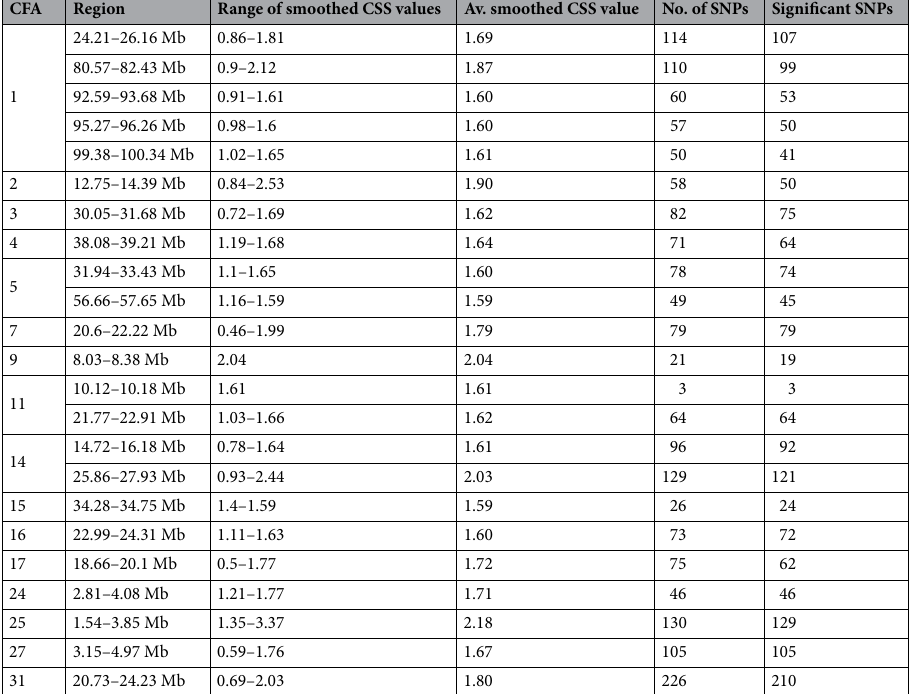
Table 3. Selected genomic regions in Xi dogs with superior running